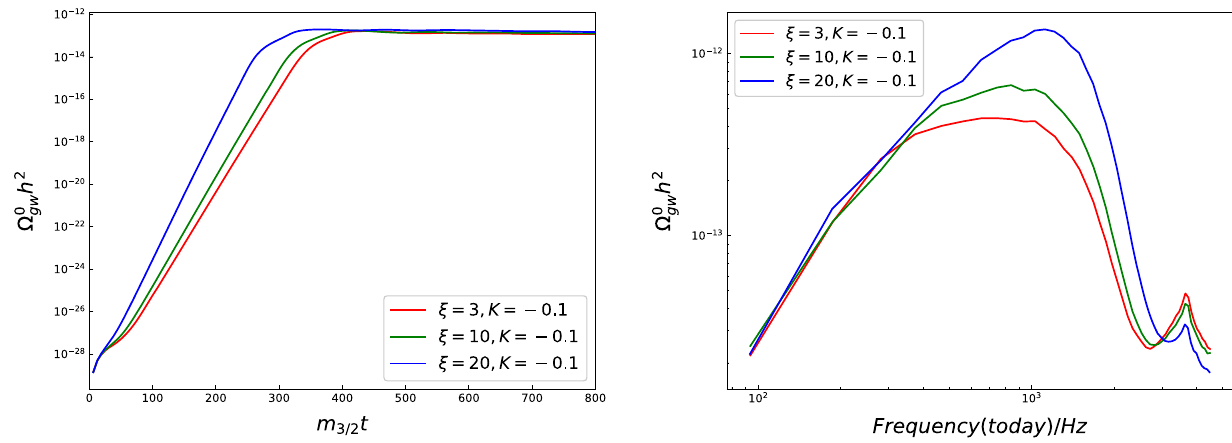
Fig. 4 Same input parameters as Fig. 3. The evolution of the present GW density parameter (cid:12) 0 g w h 2 and its dependence on the choices of ξ are shown in the left panel. The frequency bands of the GWs from Q-ball formation at the frequency ranging from 100 Hz to 10 3 Hz in each case are shown in the right